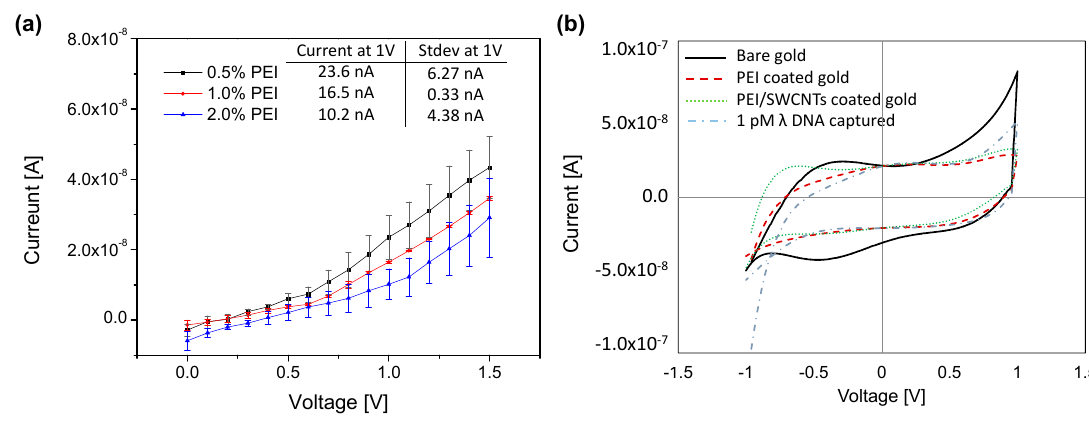
Figure 4. ( a ) IV curve for the SWCNTs coated microneedle with various concentration of PEI; ( b ) Cyclic voltammetry for four different types of surfaces: bare gold, 1% PEI-coated, 1% PEI/SWCNTs-coated microneedle, and 1 pM λ DNA captured needle.